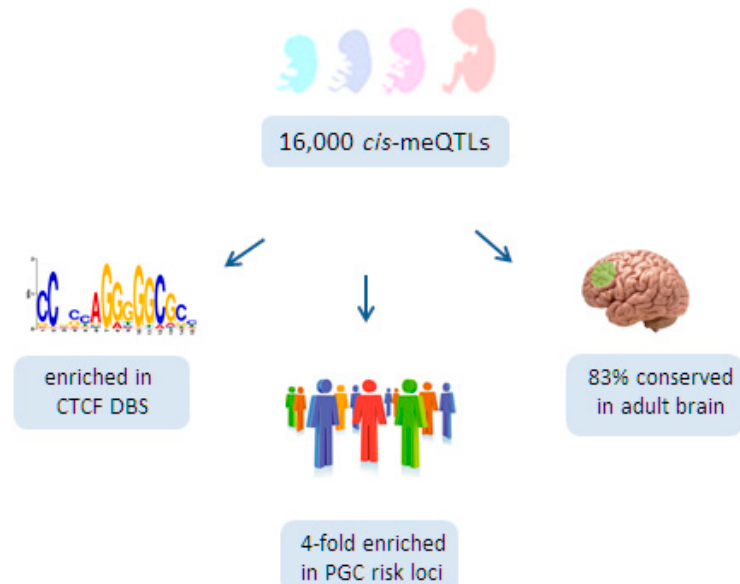
Figure 4. A role for fetal cis -meQTLs in schizophrenia. Hannon et al. [125] detected 16,000 cis -meQTLs in fetal brains aged 56 to 166 days post-conception. Fetal brain cis -meQTLs are strongly enriched in DNA binding sites (DBS) for the transcriptional regulator CTCF. Additionally, fetal brain cis -meQTLs are four-fold enriched for genetic risk variants identified previously by the Psychiatric Genetics Consortium (PGC). Lastly, 83% of the fetal cis -meQTLs are maintained beyond fetal life in the adult brain.